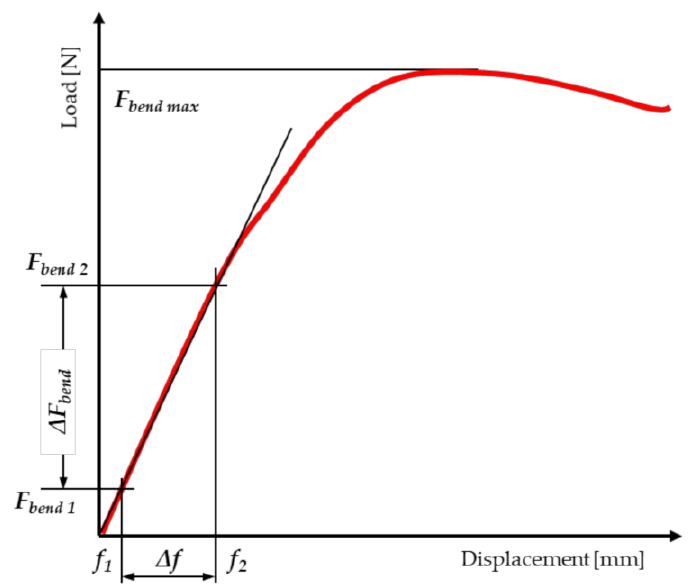
Figure 6. Dependence of force on displacement for the static compression test along the fibers of miscanthus